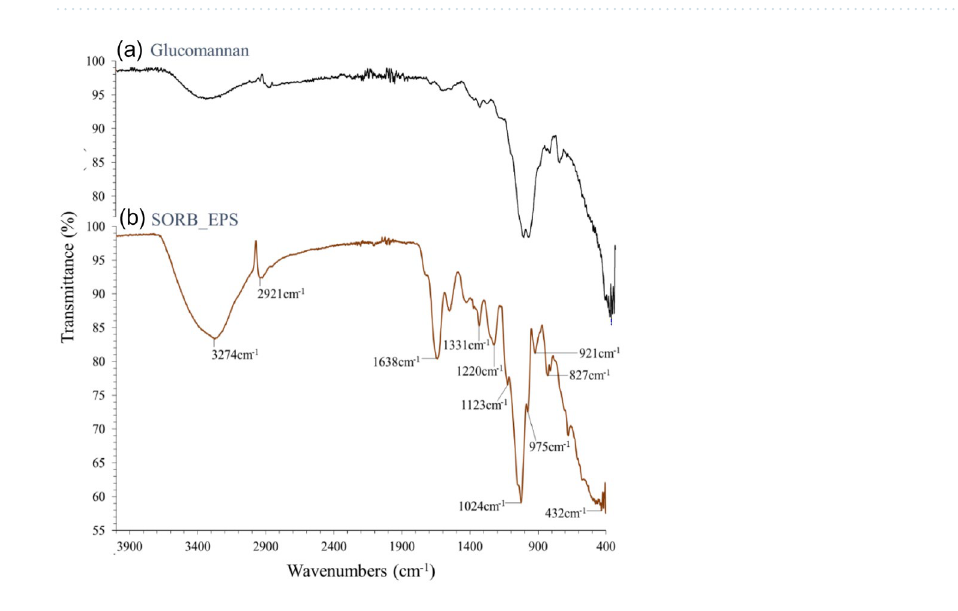
Figure 3. Study of EDX pattern ( a ), CNHS compositions ( b ), XRD pattern ( c ), and TG ( d ) of crude EPS.